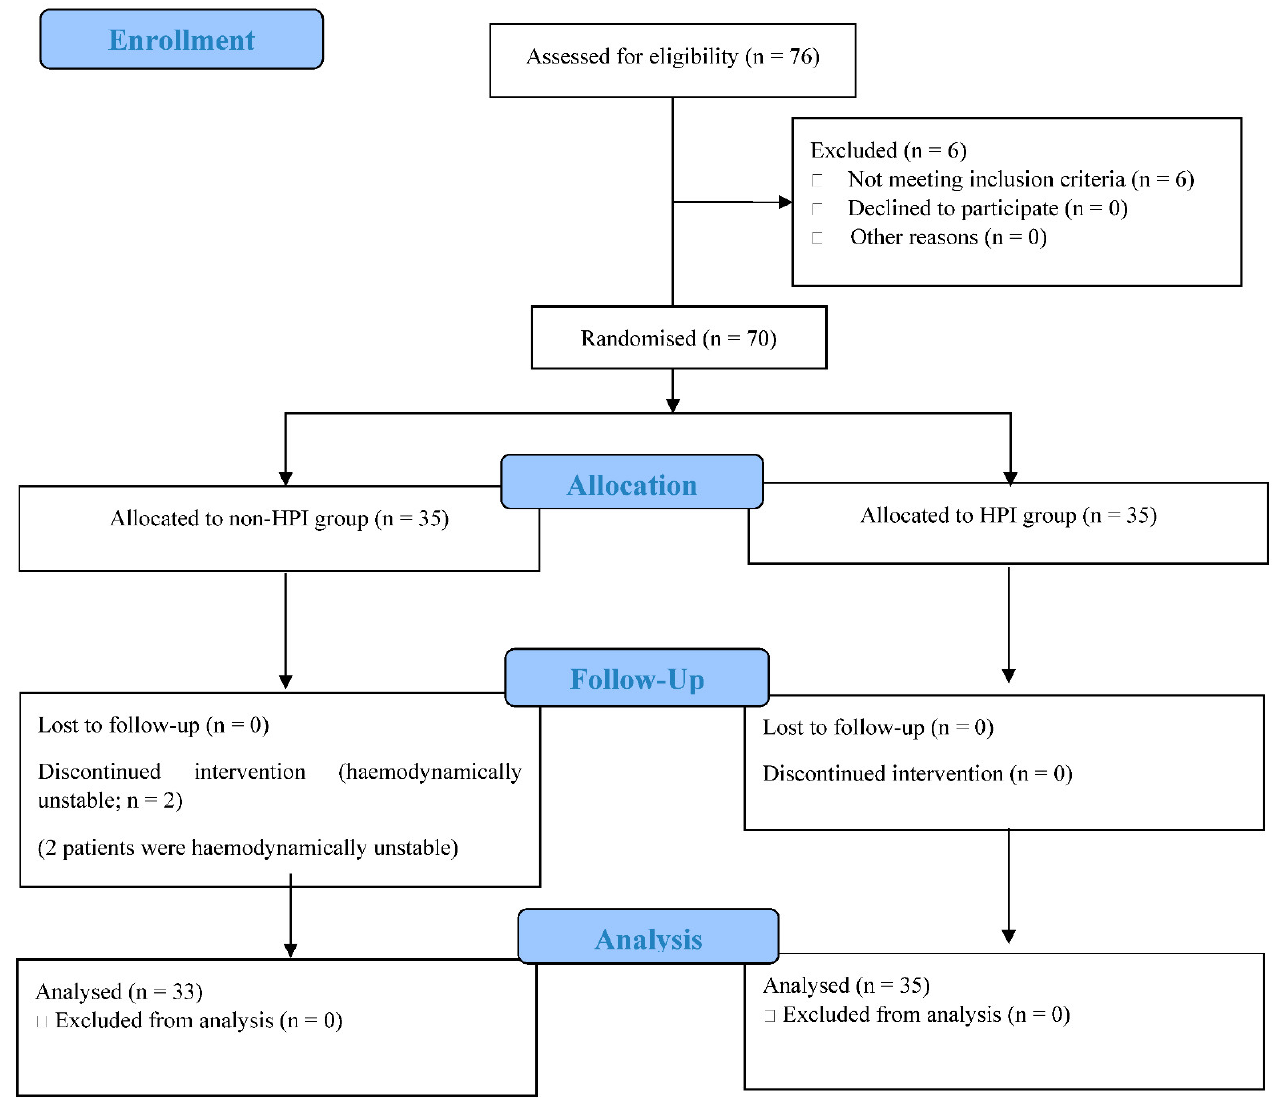
Figure 1. CONSORT flow diagram showing each stage of the randomised controlled trial; enrolment, allocation, follow-up, and analysis.